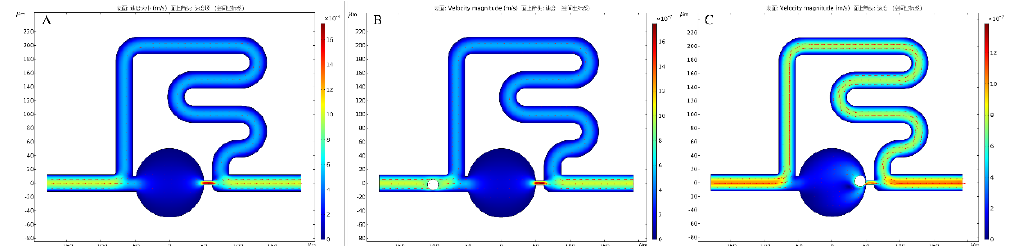
Figure 5. Simulations of flow velocity distributions of the two − dimensional channel. ( A ) Flow ve- locity distributions without cell in the channel. ( B ) Flow velocity distributions during the cell moved in the channel. ( C ) The flow velocity distributions after the cell was trapped at the capture site.